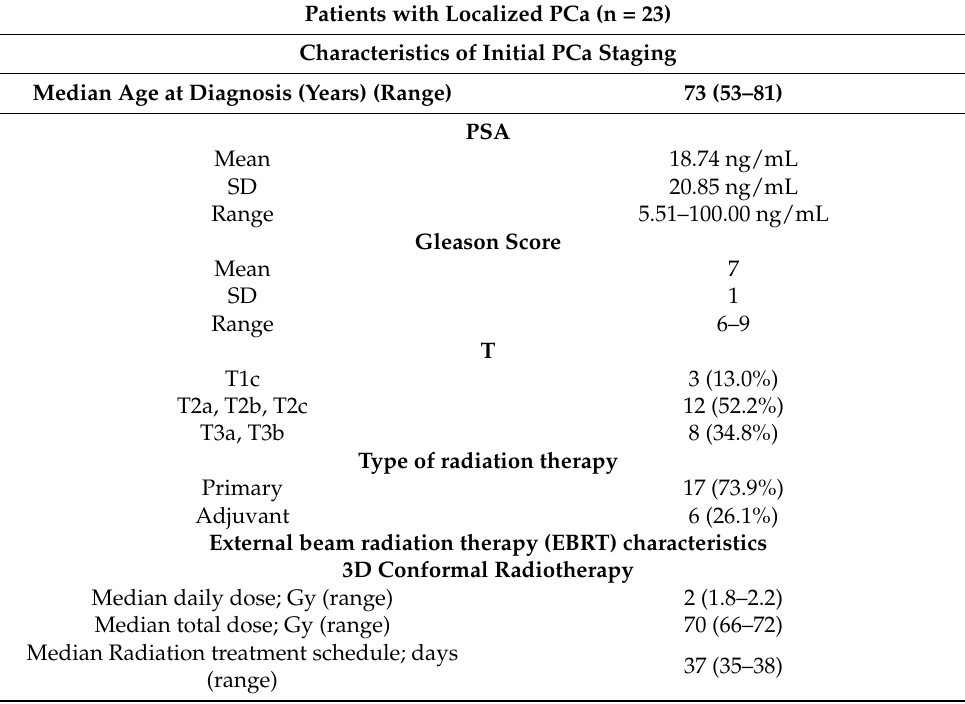
Table 1. Clinicopathological characteristics of the patients and details of the radiation